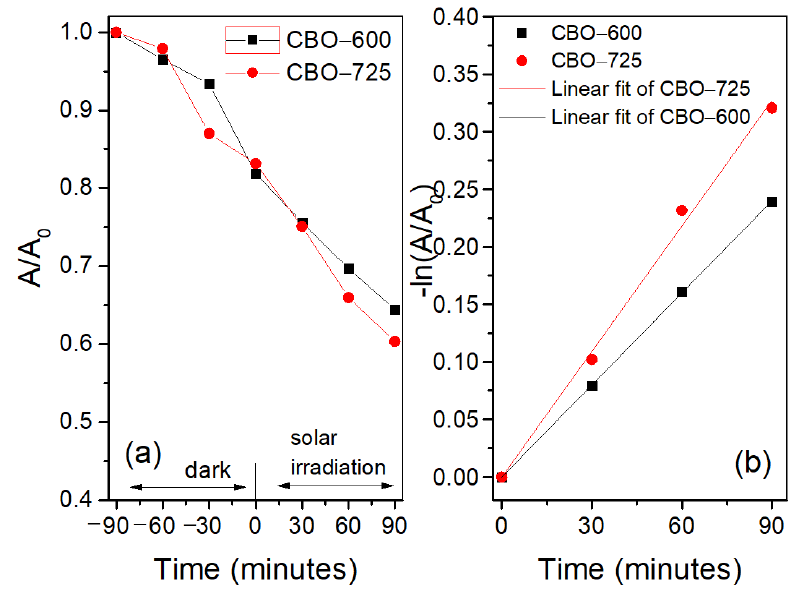
Figure 9. ( a ) RhB removal curves over CBO-600 and CBO-725 at normal pH—5; ( b ) the corresponding pseudo-first order kinetic curve.